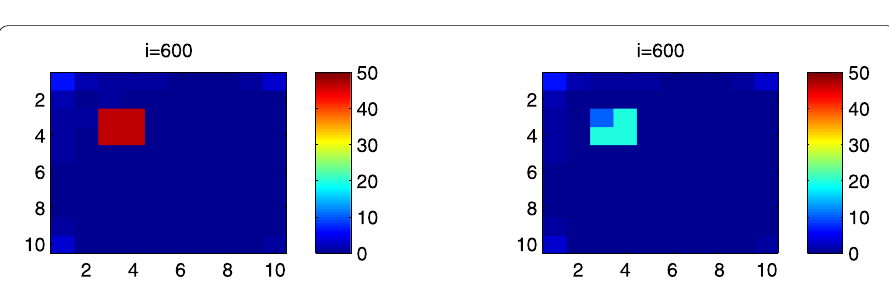
Figure 17 S Cpq behavior at instant i = 600 in the presence of optimal controls characterized in (11). On the left side, the case when the travel-blocking vicinity control approach is applied to all cells C pq ∈ P . On the right side, the case when the travel-blocking vicinity optimal control strategy is followed in P \ C 33 . The infection starts from the lower left corner cell C 1010